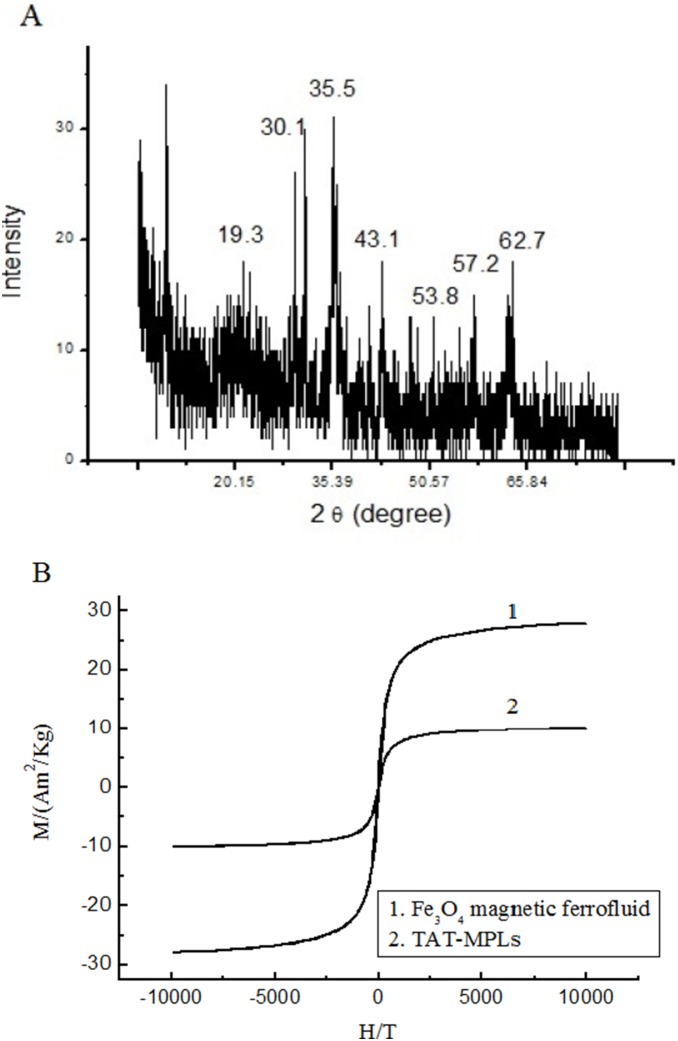
Particle-size-distribution and Zeta potential.(A) Particle-size-distribution based intensity of MPLs (1) and TAT-conjugated MPLs (2) in PBS. (B) Zeta potential of MPLs (1) and TAT-conjugated MPLs (2) in PBS.